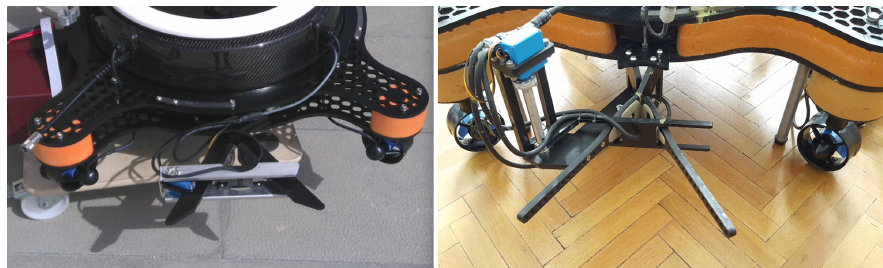
Figure 7. aPad-mounted docking mechanism comparison, initial design ( left ) and final design ( right ).